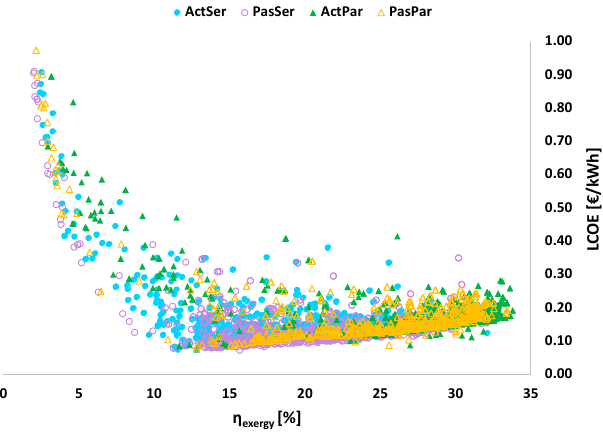
Figure 7. The assessed area by the optimization algorithm to find a minimum for each scenario.